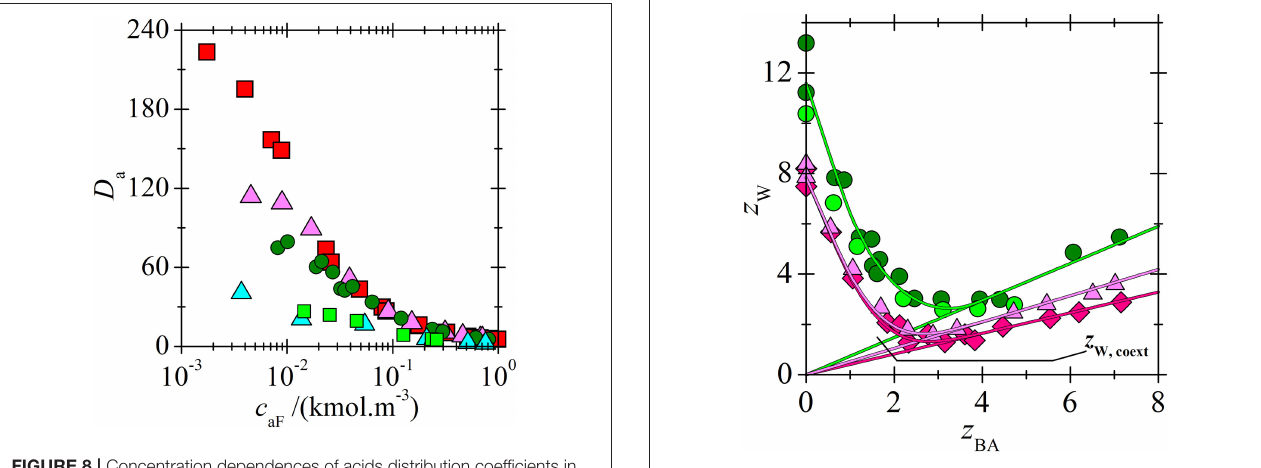
Table 2 . A comparison of the results with LA and BA extracted by [C 14 C 6 C 6 C 6 P + ][BTMPP − ] shows that the value of K W,coext is higher for LA than for BA, which can be attributed to the higher polarity of LA.